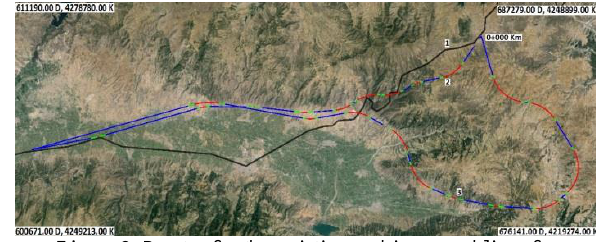
Figure 3. Routes for the existing and improved lines for